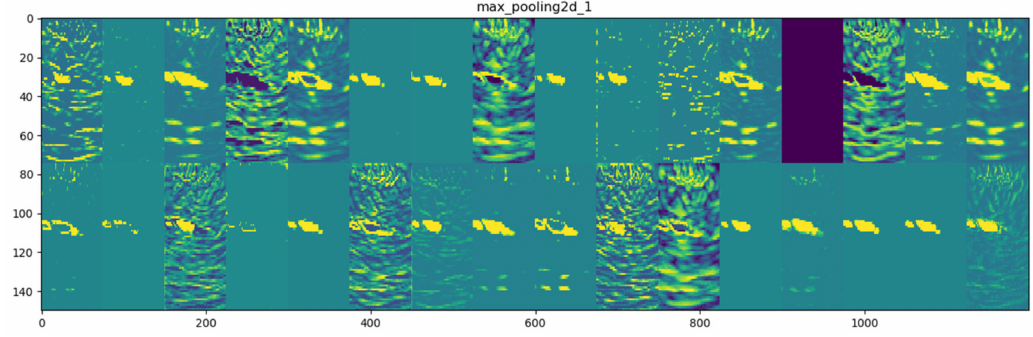
Figure 14. Visualization of 2 × 16 filters after the first max pooling